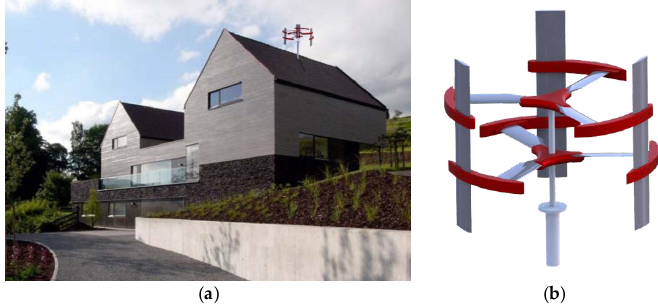
Figure 7. ( a ) Artist’s impression of a building integrated CAWT; and ( b ) CAD design of the CAWT.